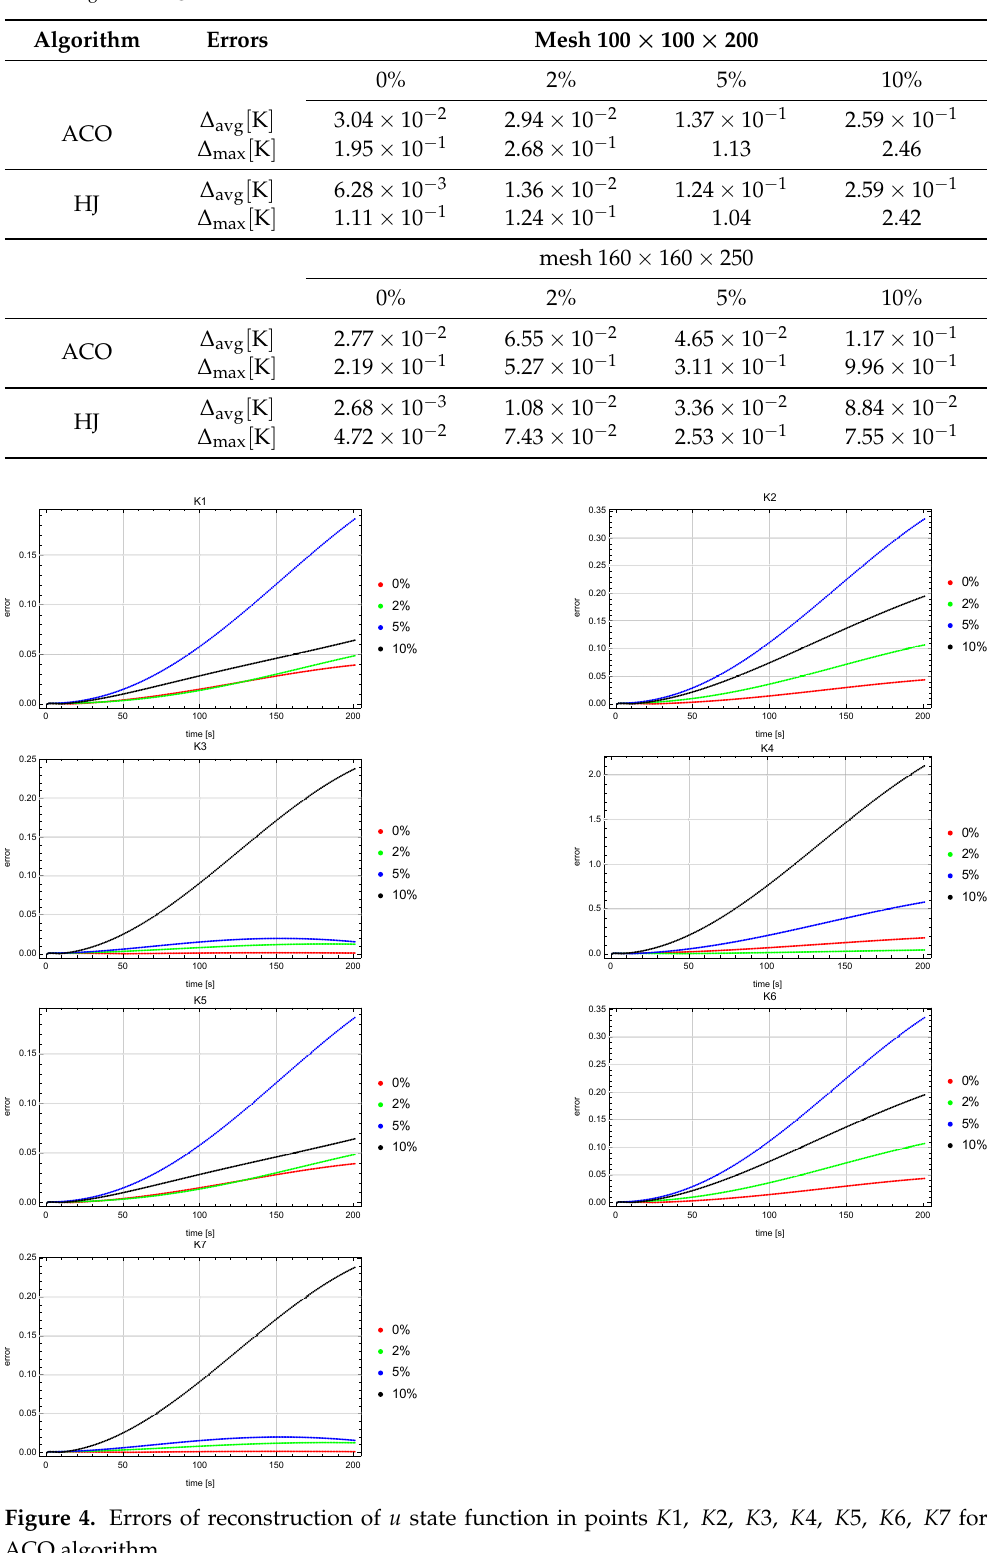
Table 3. Errors of reconstruction function u in grid points in case of reconstruction of two parameters λ , α ( ∆ avg —average absolute error; ∆ max —maximal absolute error).